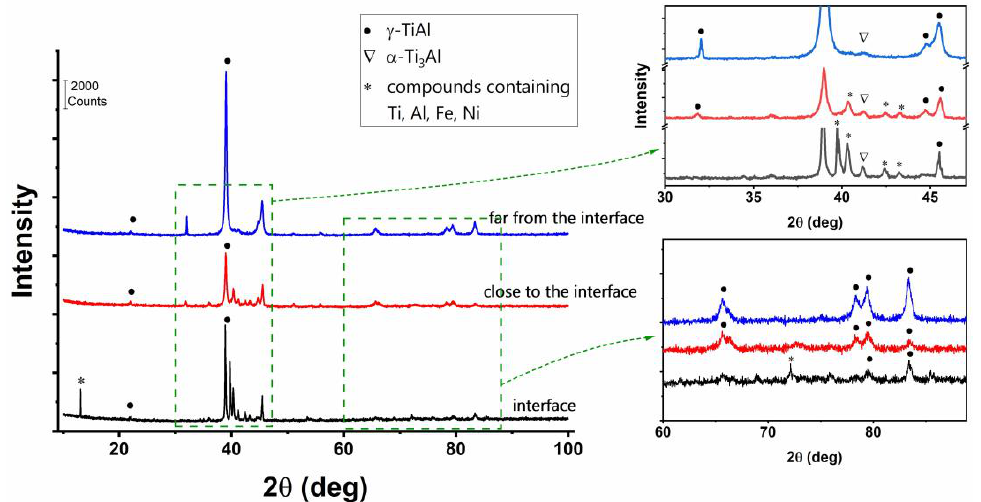
Figure 9. XRD patterns of HIPed sample at different locations along the building direction.